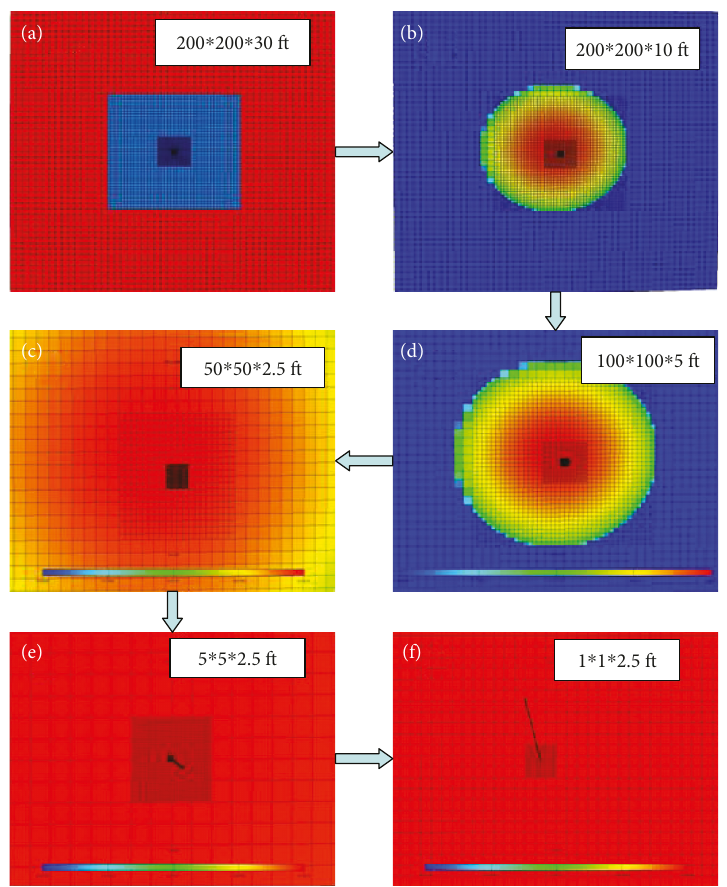
Figure 2: The procedure of nested grid systems, in which the size of the grid cells in each direction can be reduced step by step until the size of the near wellbore grid cells is close to the radius of the wellbore. (a) The basic con fi guration of nested grid systems. (b – f) The distribution of oil saturation, which indicates that the size of nested grid cells will be reduced from 200 ∗ 200 ∗ 10 ft to 1 ∗ 1 ∗ 1 5ft .